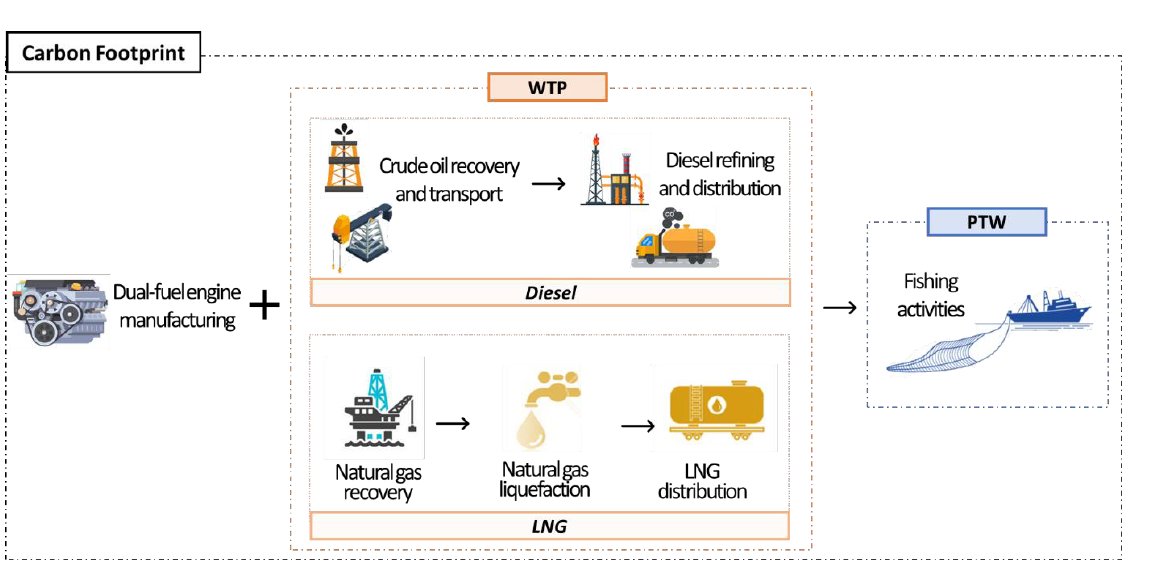
Figure 8. The LCA of an LNG-powered trawler.